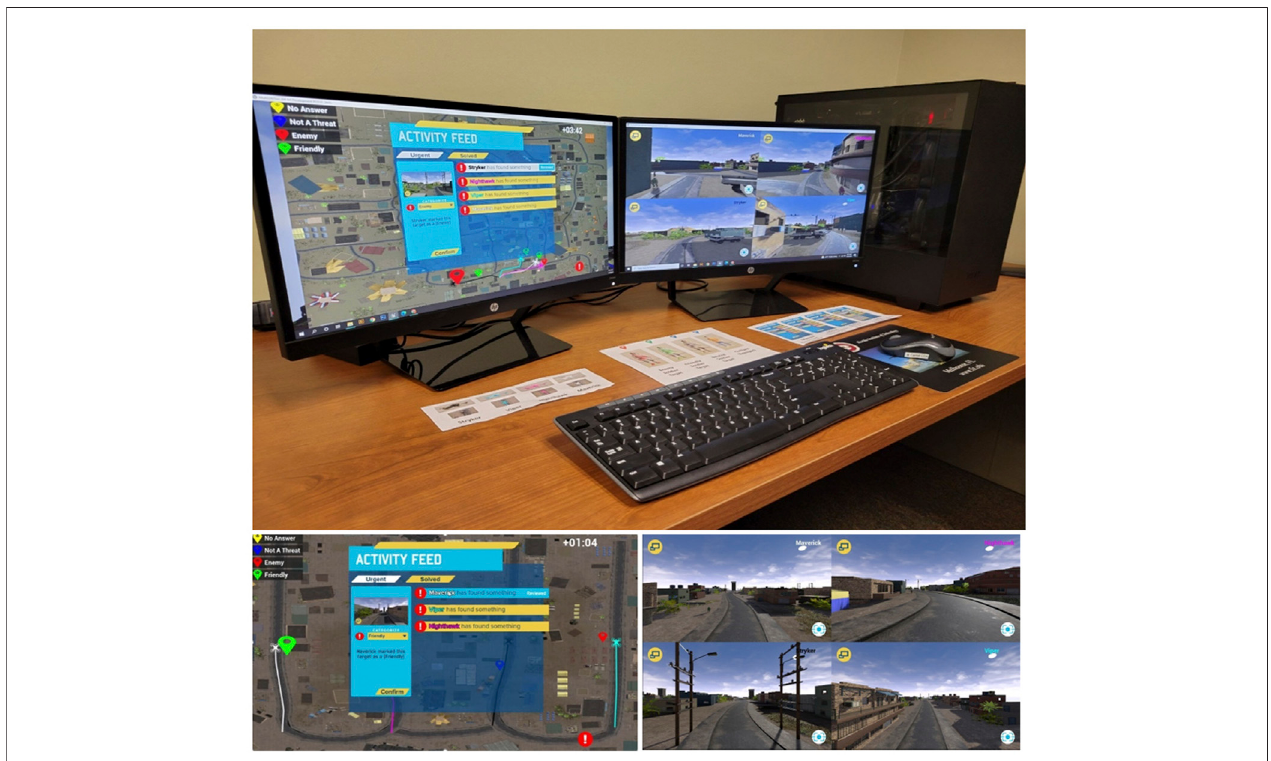
FIGURE 2 | Experimental